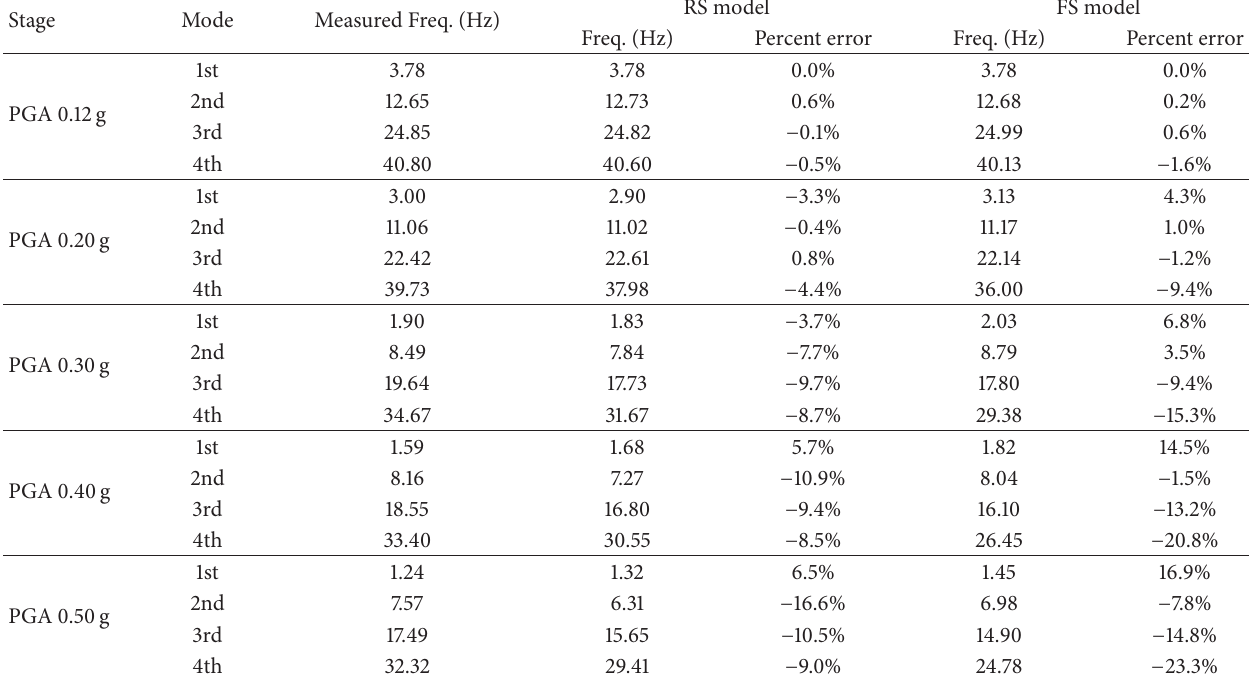
Table 4: Comparison of measured and analytical natural frequencies.